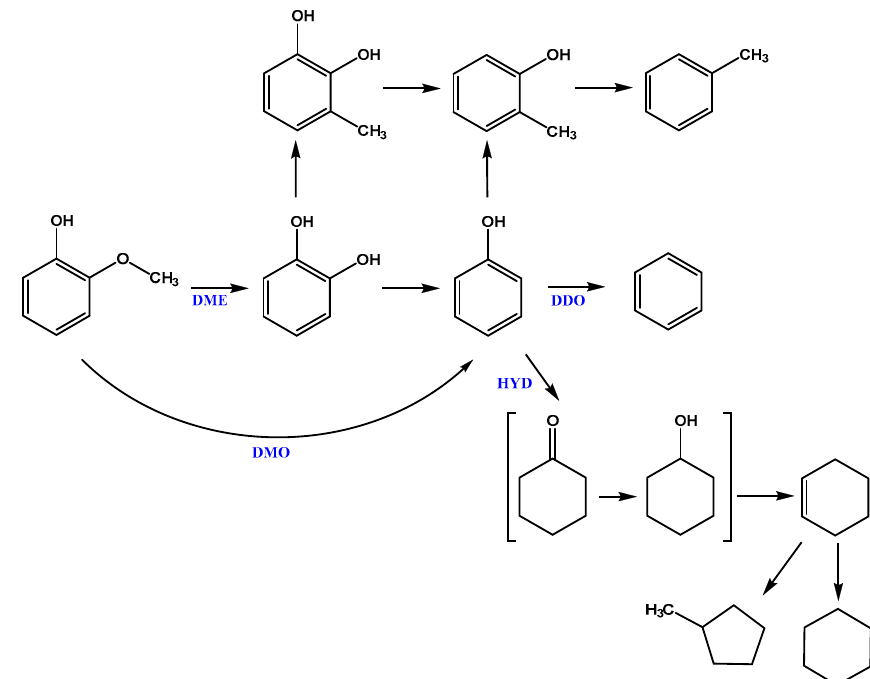
Scheme 1. Proposed reaction network (a reverse Mars van Krevelen reaction pathway) for coupled HDO and alkylation reaction on the surface of POM/TiO 2